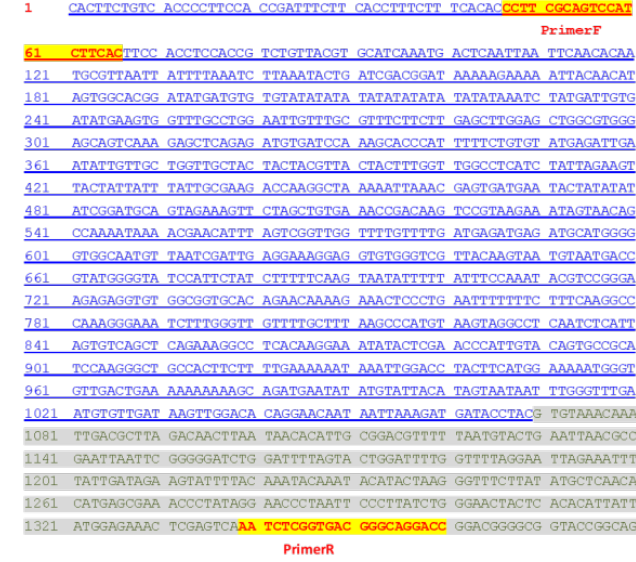
Figure A2. Sequencing results of PCR amplification product of bar and flanking region from genome DNA of 3-1 ( A ) and 31-1 ( B ) soybean. Bar gene’s sequences are in gray, genome DNA sequences are underlined, primers are highlighted in yellow.